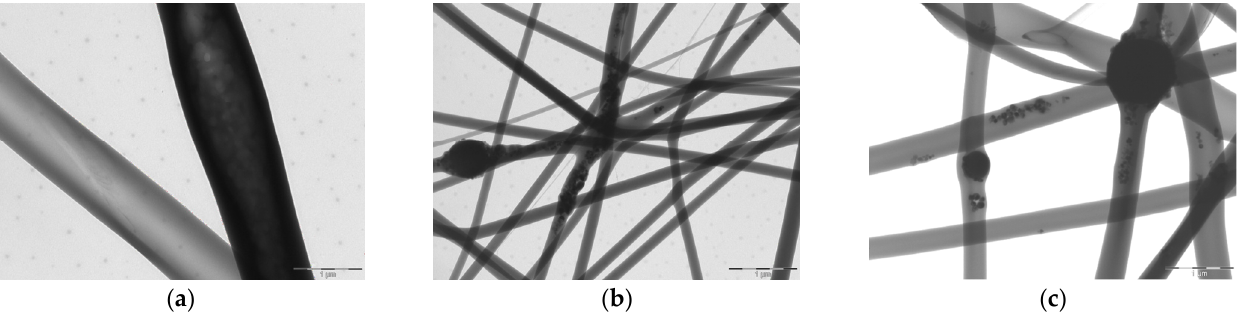
Figure 1. TEM microphotographs of spare electrospun fibers (scale bar 1 μ m) made of B ( a ), 0.1 HP ( b ) and 0.5 HP ( c ) blends, showing the disposition and morphology of HP inclusion in individual fibers. Scale bar is 1 μ m.